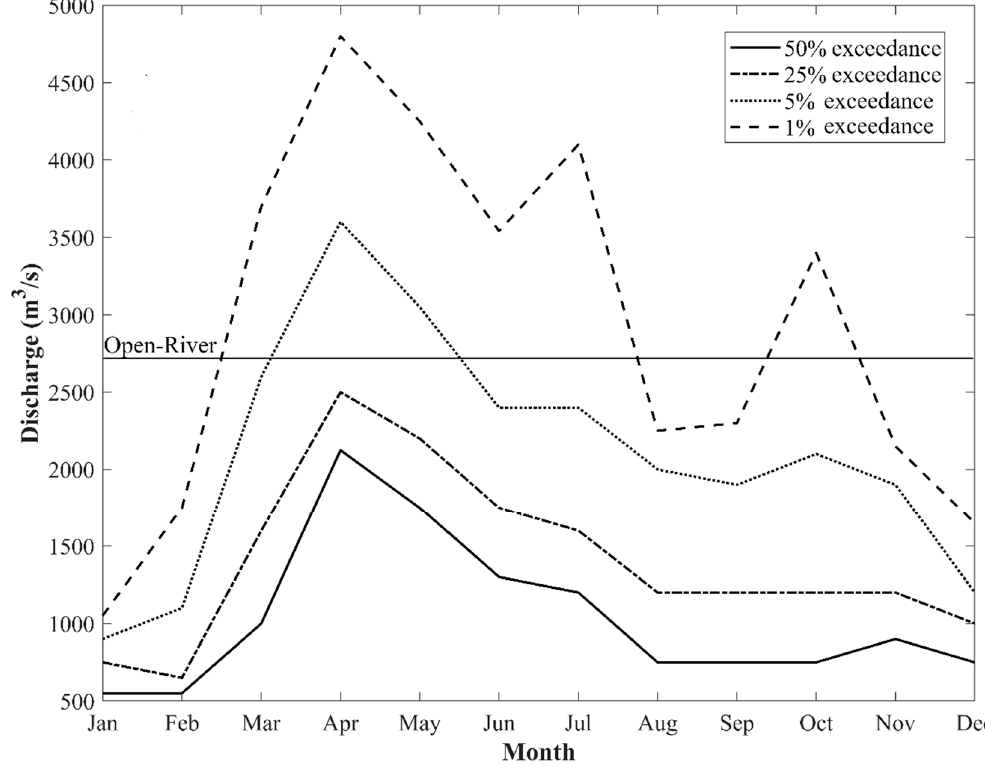
Figure 2. Schematic representation of the stochastic size-structured fish passage model (S-FPM). The model uses a silver carp population with five size classes that are released in Pool A (downstream).